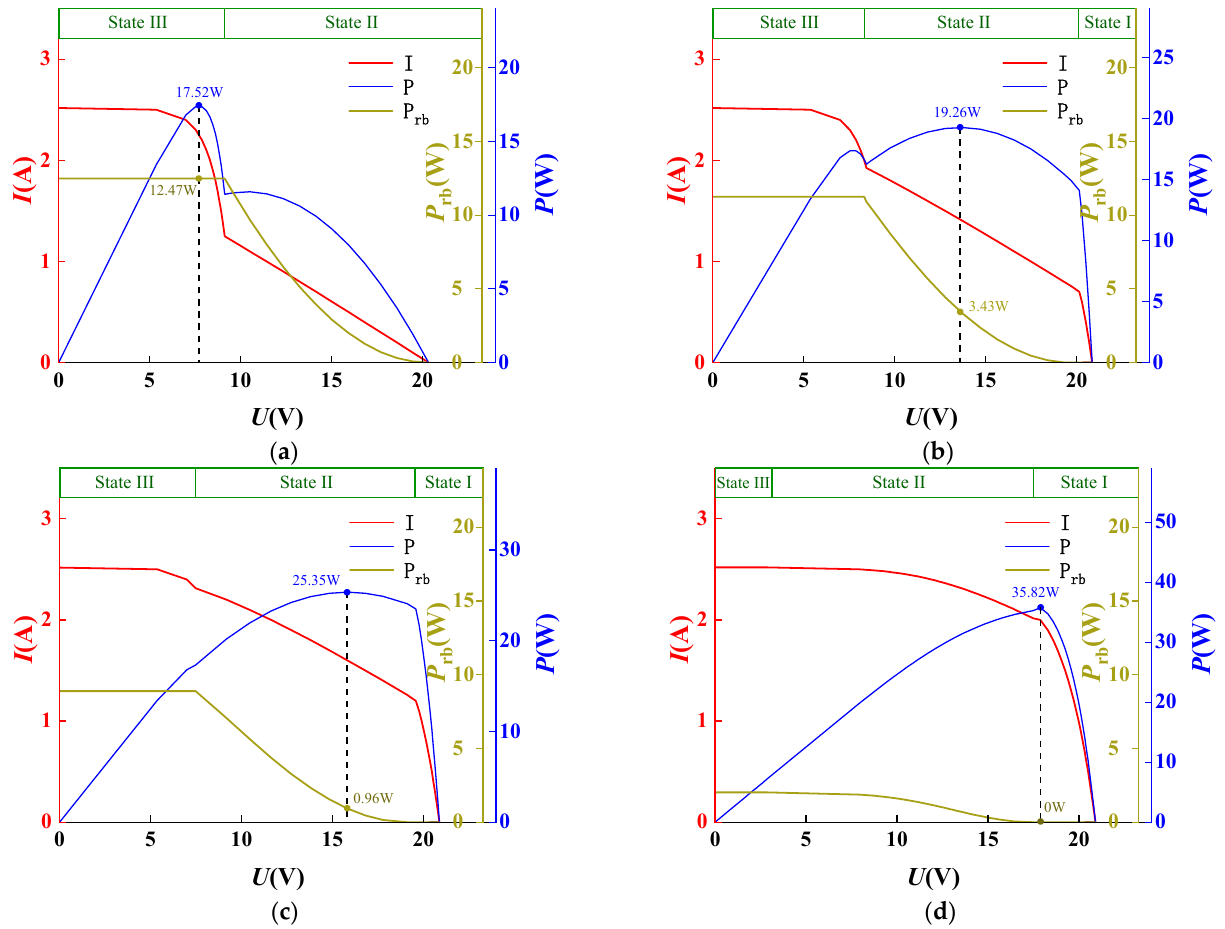
Figure 6. Output characteristics of low resistance hot-spot photovoltaic modules at different β : ( a ) β = 0; ( b ) β = 0.3; ( c ) β = 0.5; and ( d ) β = 0.8.